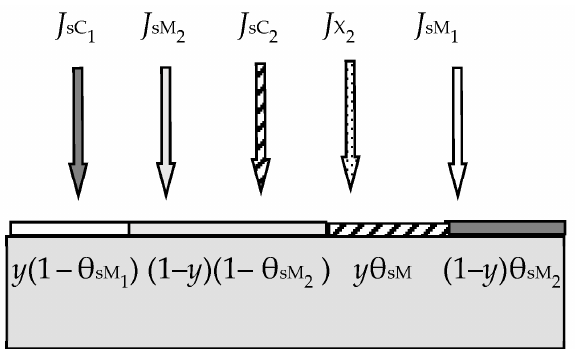
Figure 6. The fl uxes on the target surface. Notations: J tM M 1 ; J tM is the fl ux density of spu tt ered metal atoms M 2 ; J tC 2 molecules; J tC is the fl ux density of spu tt ered M 2 X molecules; θ tC 2 covered by the compound fi lm M 1 X; θ tC pound fi lm M 2 X.